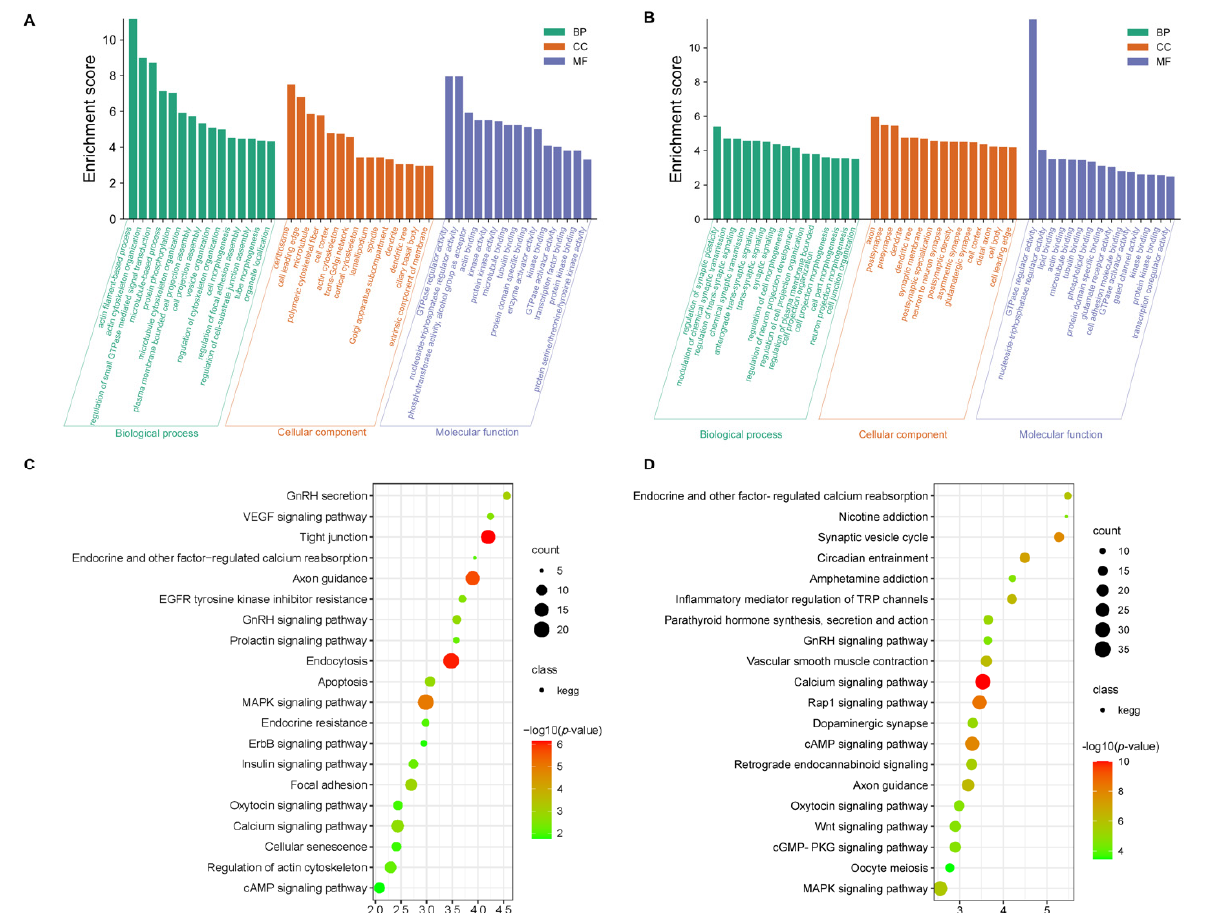
Figure 4. TOP enriched gene ontology (GO) study of differential expressed genes between short-photoperiod and long-photoperiod in the hypothalamus and distal pituitary of sheep. ( A ) GO enrichment terms for DEGs in SP21 − HYP vs. LP21 − HYP. ( B ) GO enrichment terms for DEGs in SP21 − PD vs. LP21 − PD. KEGG pathway analysis for DEGs between short photoperiod and long photoperiod in hypothalamus and PD of Small Tail Han sheep. ( C ) 20 enrichment pathways in SP21 − HYP vs. LP21 − HYP. ( D ) 20 enrichment pathways in SP21 − PD vs. LP21 − PD. Rich factors are defined as the amount of differentially expressed genes enriched in the pathway/amount of all genes in the background gene set.